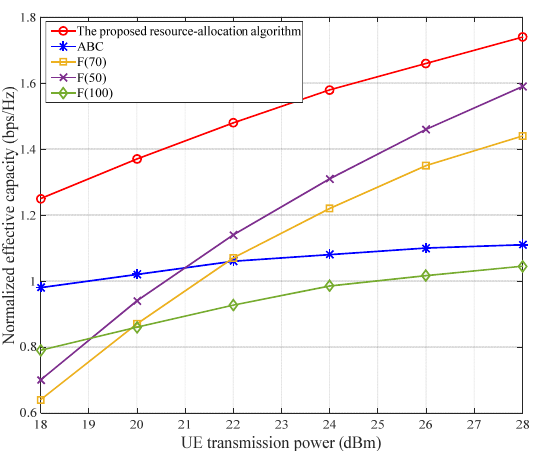
Figure 8. Relationship between normalized effective network capacity and UE-transmit power for evenly distributed network users.